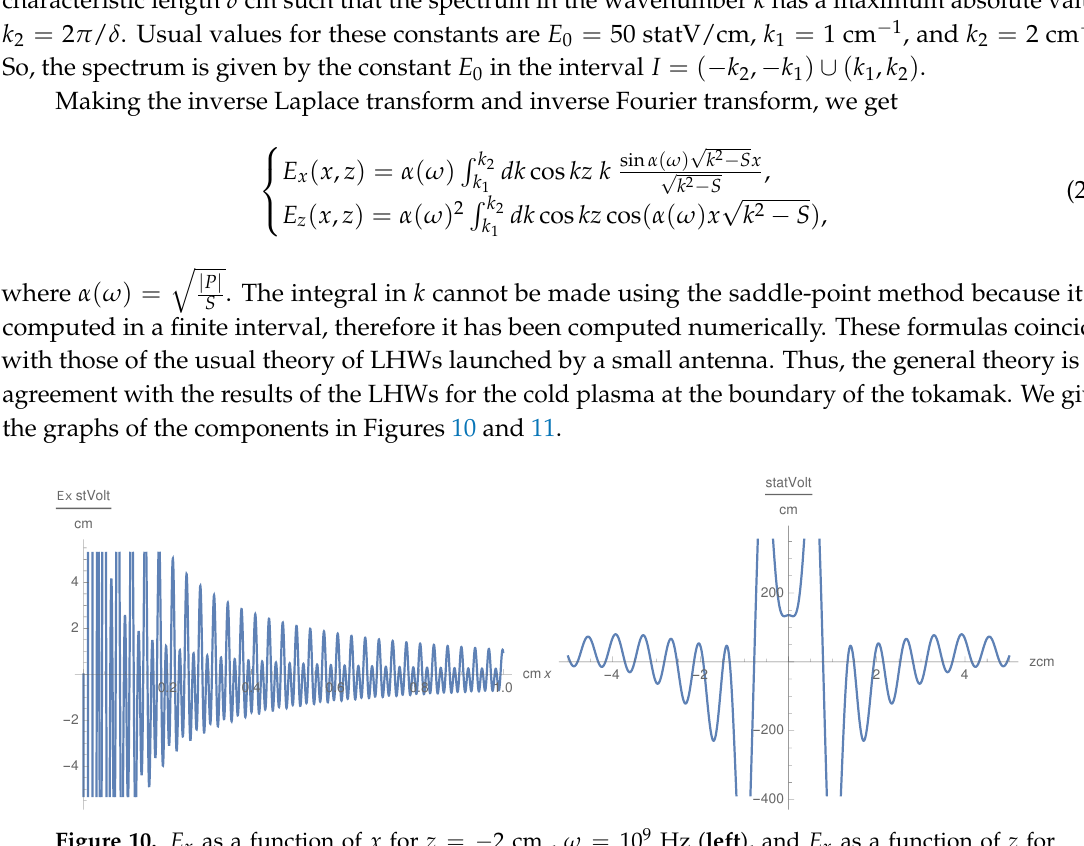
Figure 10. E x as a function of x for z = − 2 cm , ω = 10 9 Hz ( left ), and E x as a function of z for x = 0.004 cm and ω = 10 9 Hz ( right